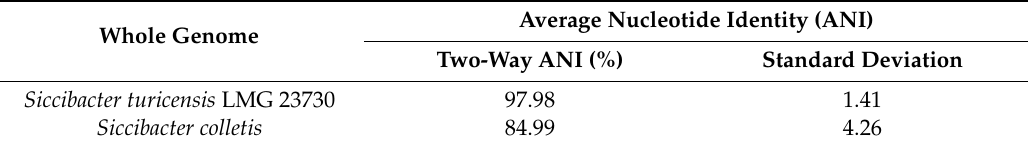
Table 2. Average nucleotide identity of #493 isolate with two closely related organisms.